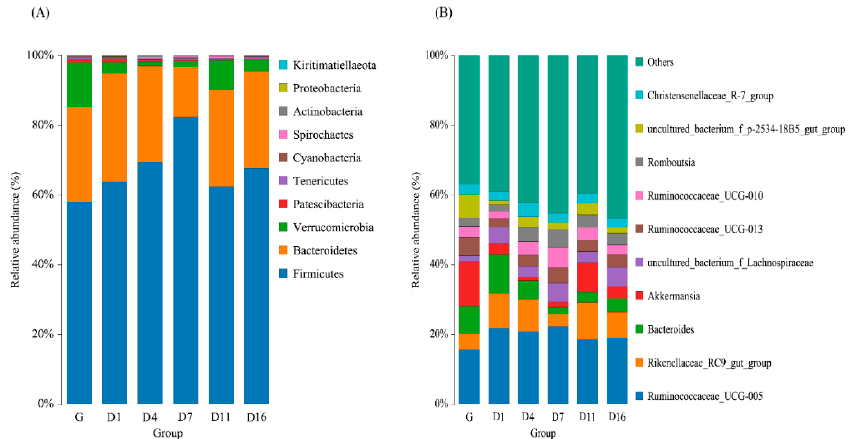
Figure 3. Phylum ( A ) and genus ( B ) (relative abundance) composition for fecal samples collected from G (grazing) group and D1, D4, D7, D11, and D16 (feedlot feeding days 1, 4, 7, 11, and 16, respectively).